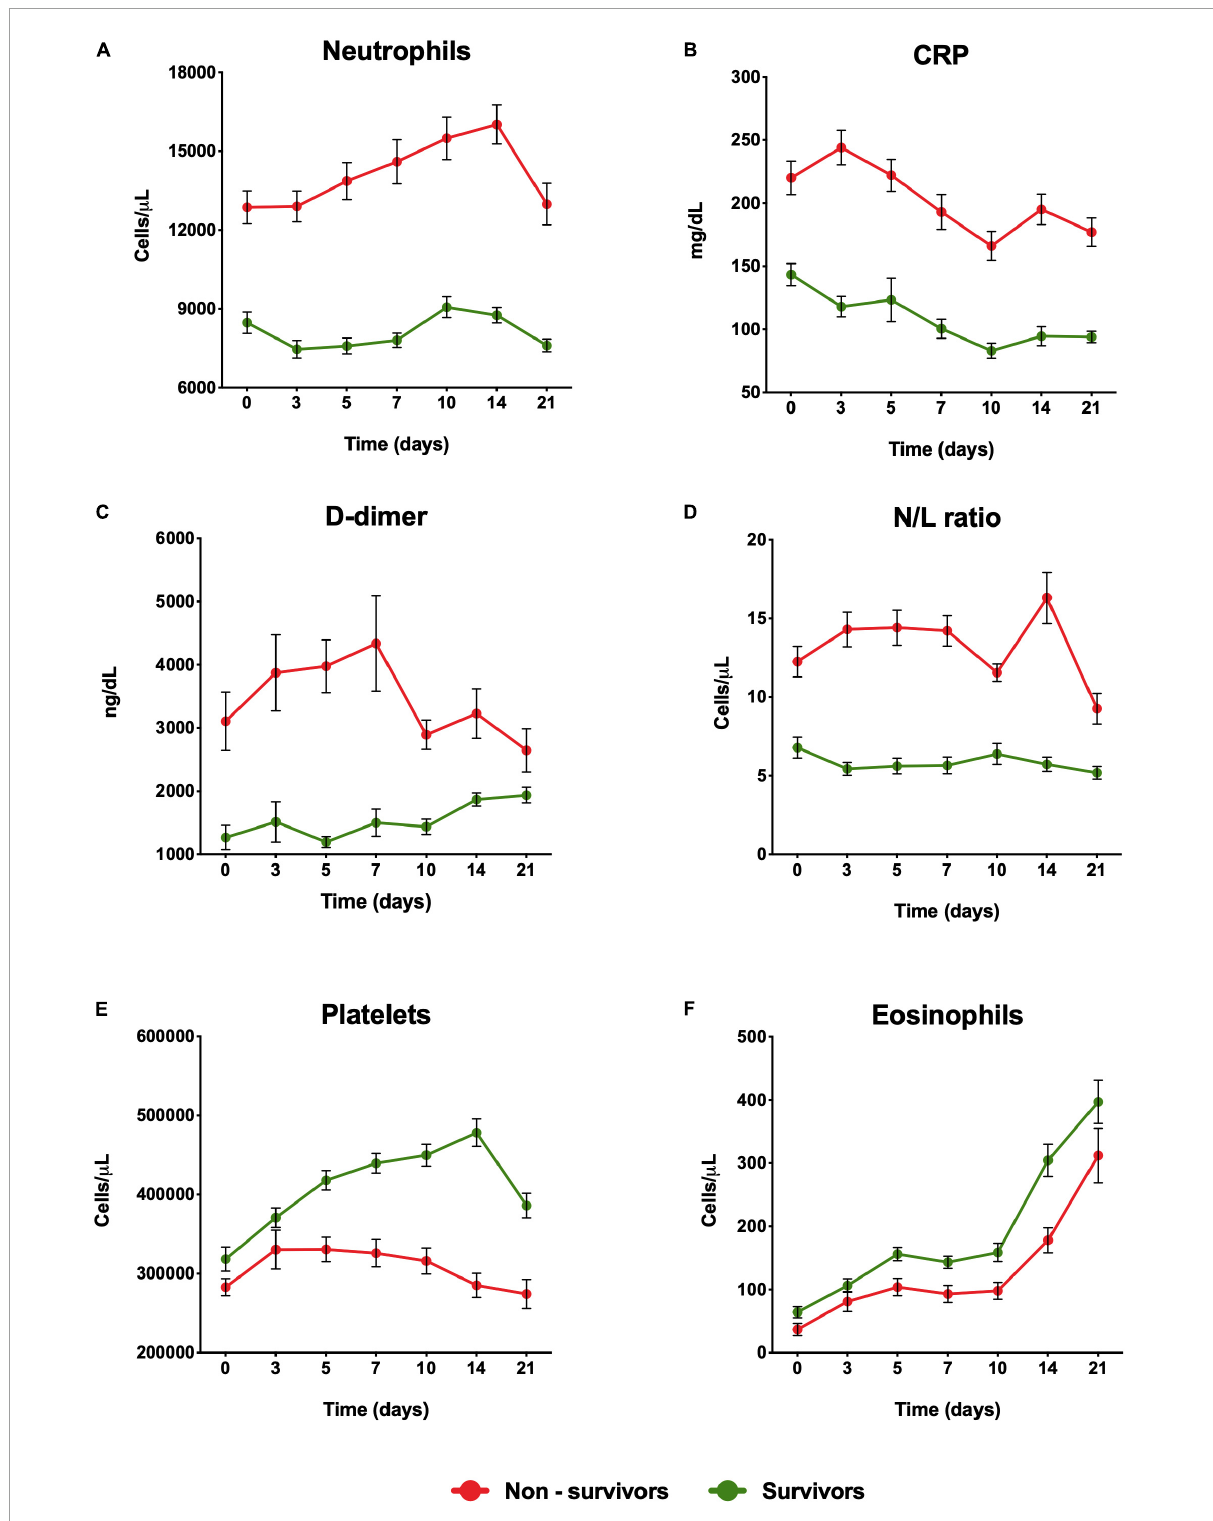
FIGURE2 Dynamical changes in the levels of risk factors in severe COVID-19 patients during hospitalization. (A) Neutrophil, (B) CRP, (C) D-Dimer, (D) N/L ratio, (E) Platelets, (F) Eosinophils in patients within 21 days from admission onset. The patients were stratified into a non-survival group and a survival group. Data represents mean ± SD. CRP, C-reactive protein; N/L ratio, neutrophil-to-lymphocyte